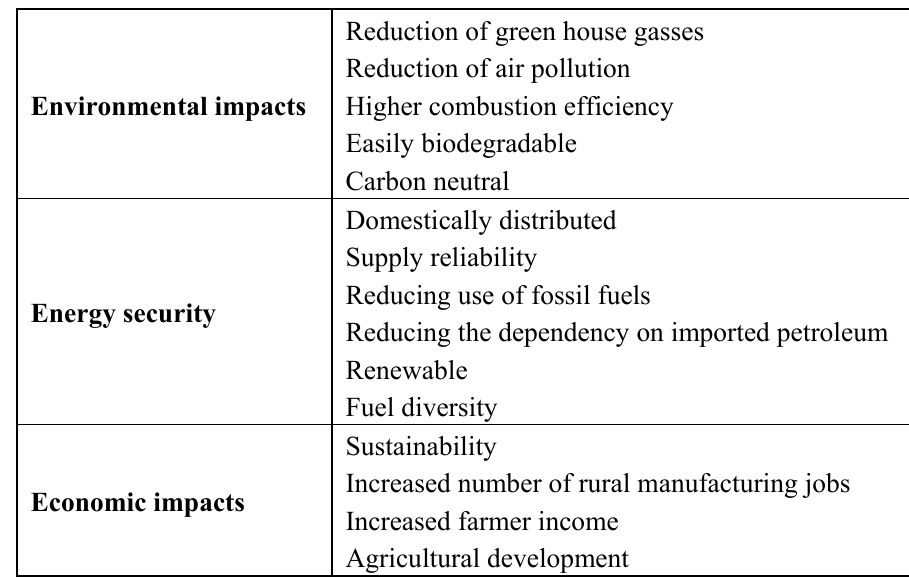
Table 1. Major benefits of